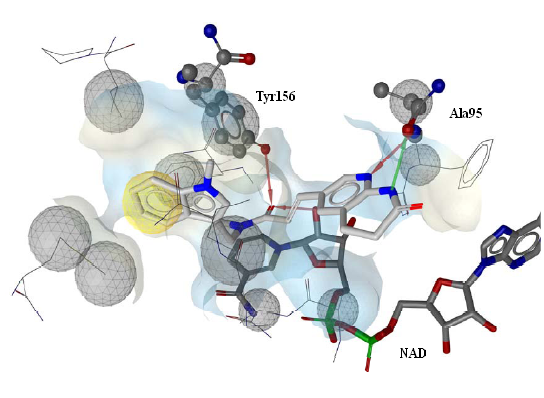
Figure 1. ( a ) LigandScout pharmacophore model generated from FabI-compound 20 crystal structure (red arrows, HBA; green arrow, HBD; yellow spheres, hydrophobic sites; gray spheres, excluded volumes); ( b ) Schematic 2D molecular interactions plot of compound 20 with residues of the FabI binding